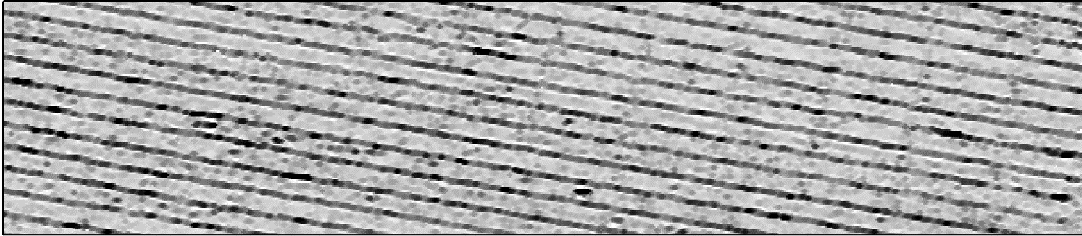
Figure 10. A majority- or modal-filter was used to convert LDF results (Figure 9) into a better approximation of lines and non-features.